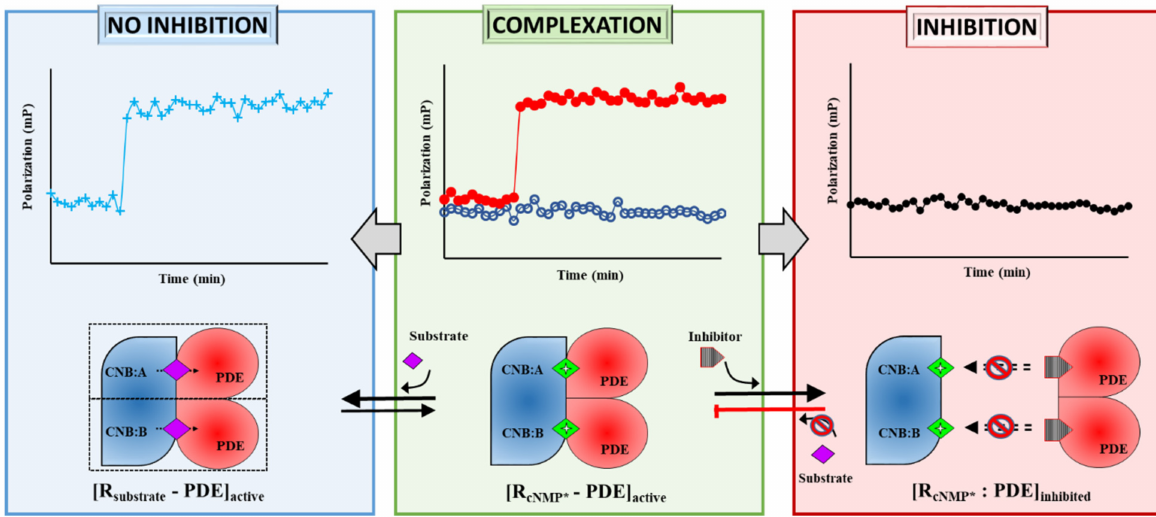
Figure 5. PDE–PK composite site as the new target for drug discovery. (Center panel) The cyclic nucleotide binding domains (CNB) of protein kinase, the ‘receptor’ (R) and catalytic site of phosphodiesterase (‘PDE’, red) coupled in the presence of fluorescent analog of cyclic nucleotide (green diamond, cNMP*) to form an [R cNMP *–PDE] active complex (red circles plot). (Left pathway) The stability and activity of the complex were tested by addition of cyclic nucleotide substrates (purple) and resulted in the competitive displacement of the fluorescent analogs and leading to a catalytic active [R substrate –PDE] complex. The displaced fluorescent analog of cAMP reassociates with PDE–PK complex resulting in increased FP (cyan plus plot). (Right pathway) Inhibitors (gray) bind to and block the active site and prevent composite site formation yielding an [R cNMP –PDE] inhibited complex as observed by no changes in FP (black circles